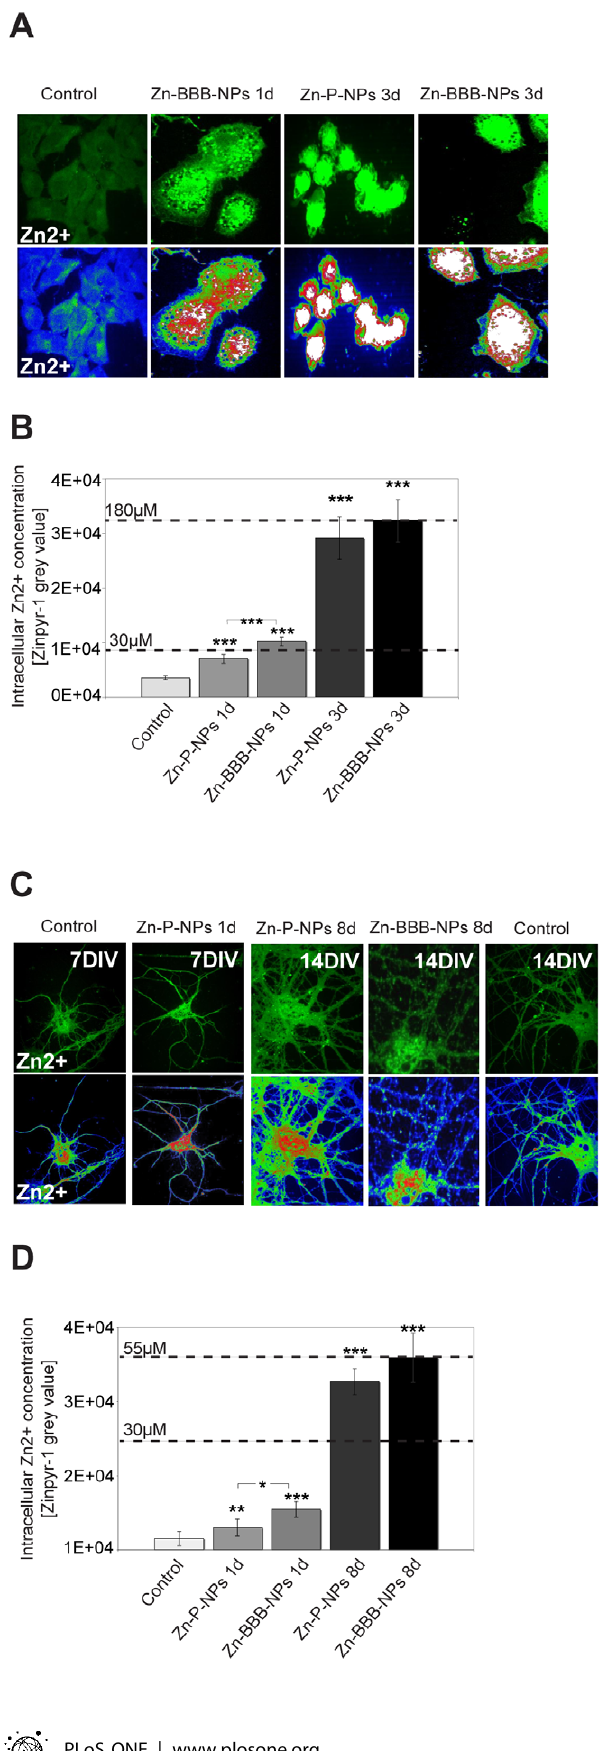
Figure 4. Intracellular Zn 2 + increase over time. A) Changes in intracellular zinc levels of HEK293 cells incubated with Zn-P-NPs or Zn- BBB-NPs for 1–3 days (End concentration: 1 mM after complete degradation) monitored by Zinypr-1 fluorescence (upper row). Color- coding of Zinpyr-1 fluorescence (lower row) reveals changes in the intracellular zinc concentration. B) Quantification intracellular zinc with Zinypr-1 (for control and ZnCl 2 reference see Fig S4.). Zinc levels in cells treated with Zn-BBB-NPs (41 m M) are significantly higher after one day compared to cells treated with Zn-P-NPs (22 m M). After 3 days, a final zinc concentration of 160 m M (Zn-P-NPs) and 180 m M (Zn-BBB-NPs) was reached. C) Hippocampal neurons were incubated with Zn-P-NPs and Zn-BBB-NPs at 6DIV and zinc levels determined by monitoring changes in Zinpyr-1 fluorescence (upper row and lower row heat-maps) at 7DIV and 14DIV (End concentration: 250 m M after complete degradation). D) After one day, Zn-P-NPs (7 m M) show a significantly lower level of intracellular zinc compared to Zn-BBB-NPs treated cells (10 m M). After 8 days, a final zinc concentration of 48 m M (Zn-P-NPs) and 55 m M (Zn-BBB- NPs) was